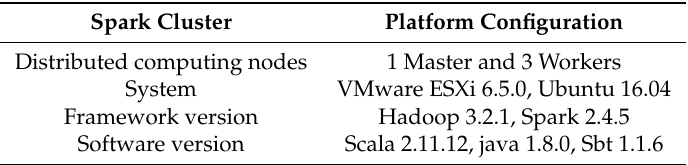
Table 1. Spark cluster for distributed computing.